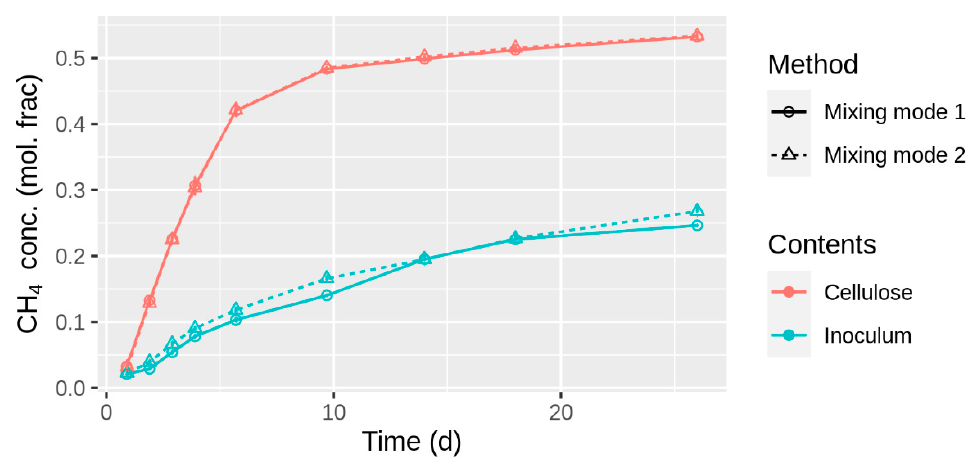
Figure 6. Methane content in the gas phase of blank and cellulose bottles for mixing mode 1 and mixing mode 2 (mean values, n = 5). The standard deviation is shown as vertical bars, which are generally smaller than the plotting symbols. Note that the CH 4 concentration is not normalized and low values are due to the dilution of biogas with flushing gas (N 2 + CO 2 ).